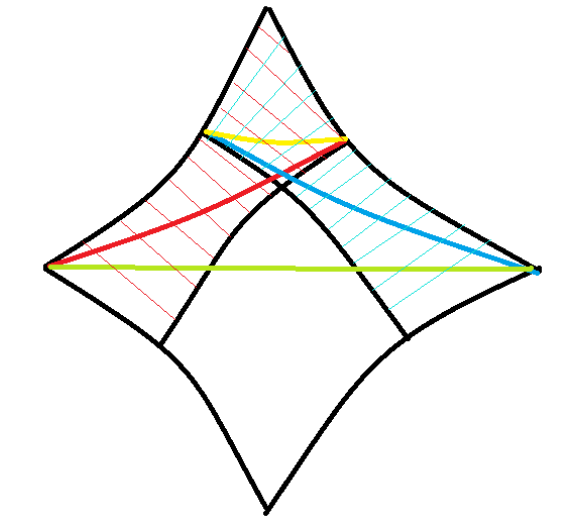
Figure 12 . The causal diamond for boosted strong subadditivity. A is the red interval, B is the blue one, A \ B is the yellow interval and A [ B is the green interval. The red diamond is D [ A ], the blue diamond is D [ B ], the intersection of them is D [ A \ B ] and the whole diamond is D [ A [ B ]. All intervals are minimal surfaces and the green interval is along (cid:28) =